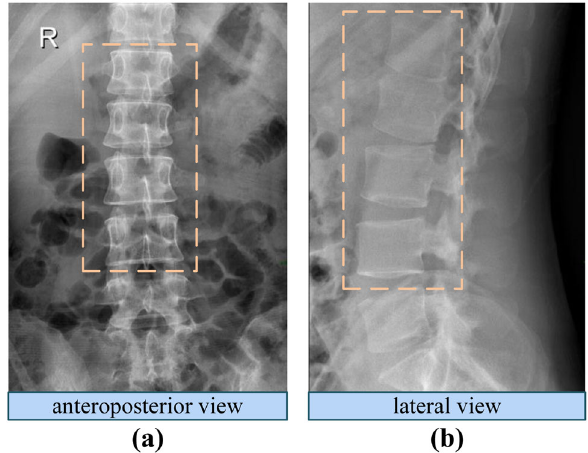
Fig. 12 Example of two lumbar spine X-ray images; the dotted box represents the first to the fourth lumbar vertebrae from top to bottom (L1–L4): a anteroposterior view and b lateral